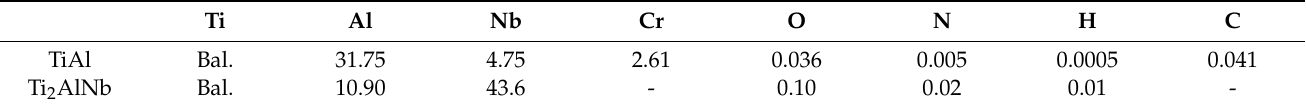
Table 1. Chemical composition of TiAl and Ti 2 AlNb